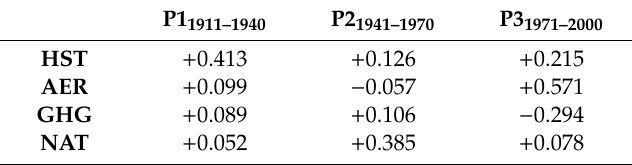
Table 4. The land-mean linear trend of the JJA-mean cloudiness from the HST, AER, GHG and NAT